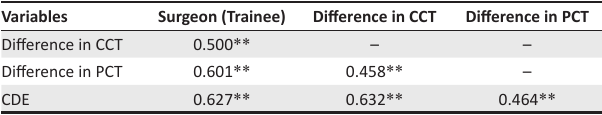
TABLE 8: Partial correlation model between surgeon type with pre- and post- operative differences in central and peripheral corneal thickness and cumulative dissipated energy, controlling for age, sex, nuclear sclerosis density and endothelium specular findings.